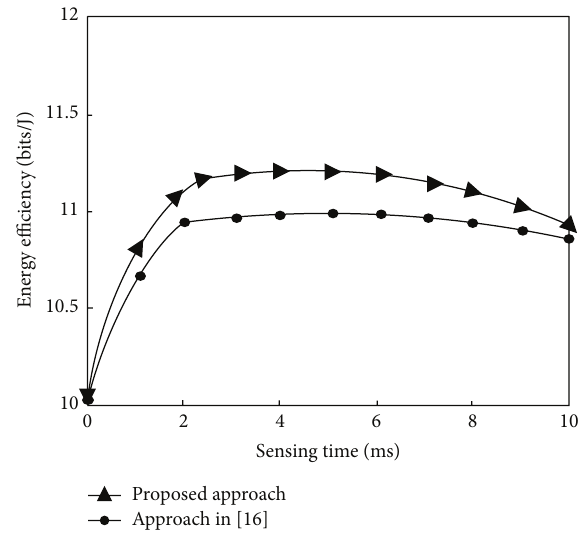
Figure 7: Comparison between proposed approach and approach in